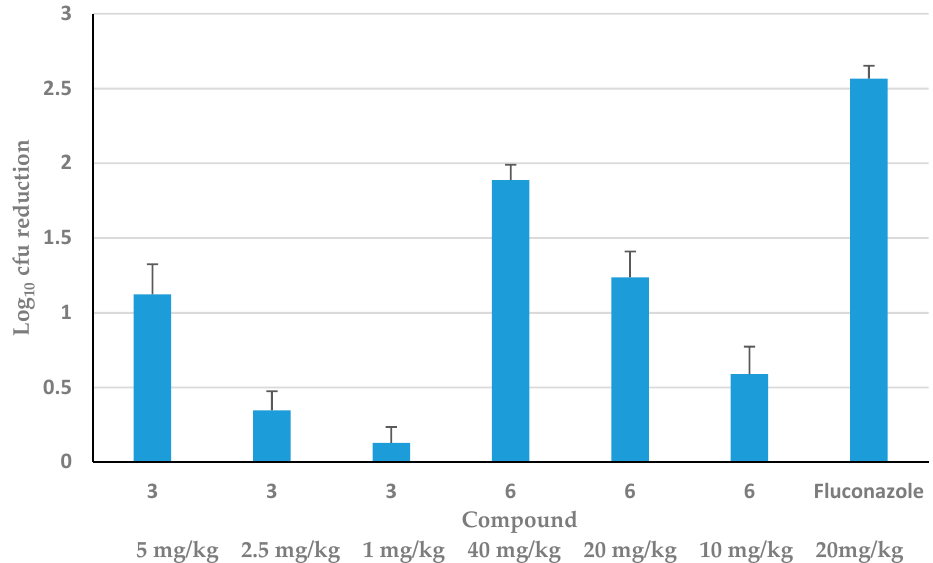
Figure 4. Dose-response of Compounds 3 and 6 in vivo. Female CD.1 mice ( n = 5 per group) were infected IV with 3.5 × 10 4 cfu/mouse before being treated 2 h later with a single SC injection of increasing concentrations of Compound 3 or 6 for 24 h. As a positive control, female Swiss CD.1 mice were also gavaged at 2 h with 20 mg/kg fluconazole for 24 h. Data are presented as log reduction in kidney burden ( ± SEM) from the mean cfu of untreated mice ( n = 5). The dose-dependent reduction in kidney burden was significant ( p < 0.05).